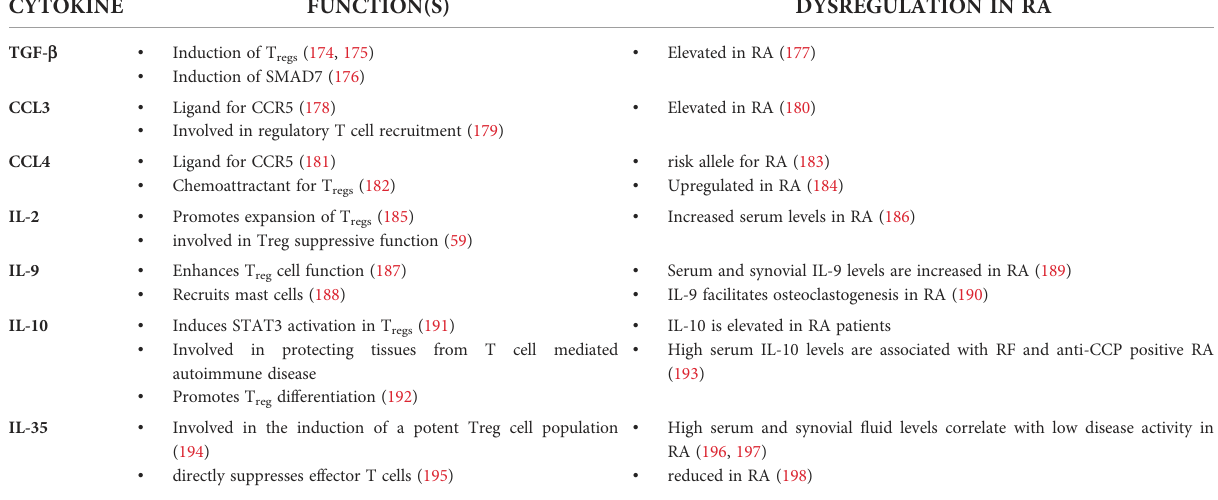
TABLE 1 Abnormal cytokine expression in RA. CYTOKINE